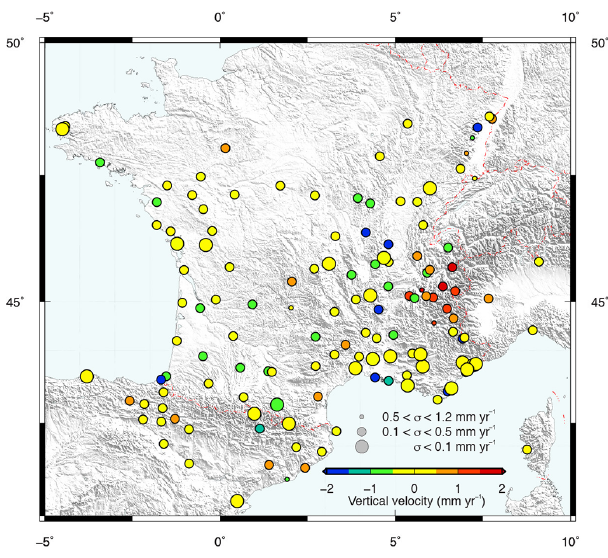
Figure 9. Vertical velocities for stations with time series longer than 5 years in the IGS08 reference frame (see Table 3 for the site